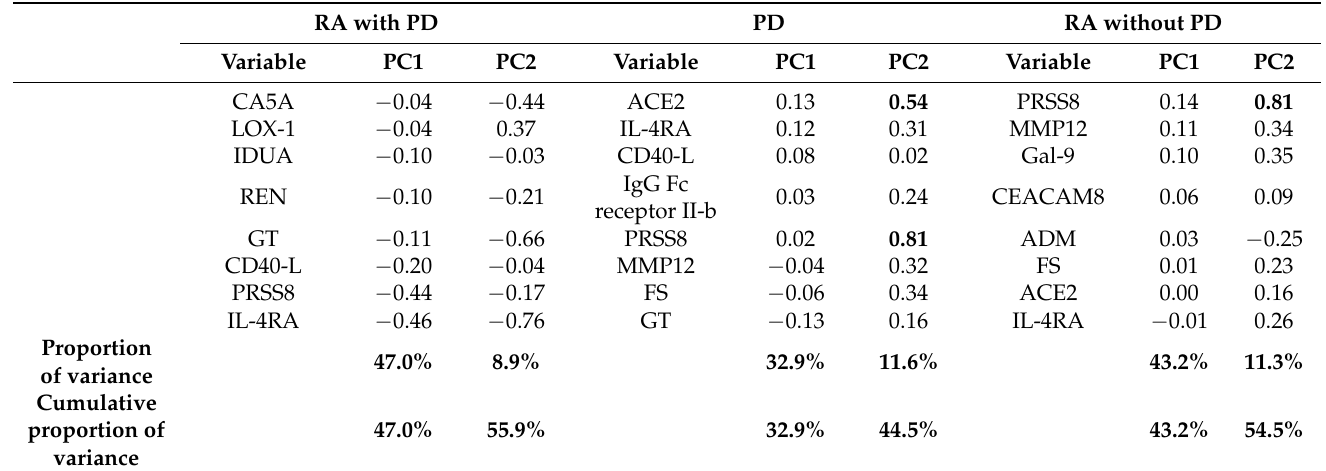
Table 2. Correlations of CVD risk biomarkers with periodontal pocketing and marginal bone